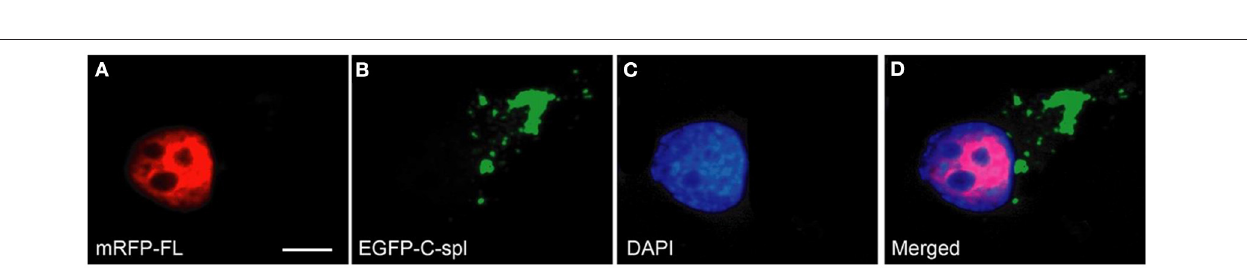
FIGURE 5 | Cytoplasmic aggregates of TDP43C-spl in neuronal cells labeled with ubiquitin antibody. N2a cells were transfected with EGFP-tagged TDP43-FL (A–D) or EGFP-tagged TDP43C-spl (E–H) . The EGFP-tagged TDP-43 isoforms are shown in (A,E) ; ubiquitin labeling in (B,F) ; DAPI stain in (C,G) ; with the respective merges shown in (D,H) . The EGFP-tagged TDP43-FL (A) co-localized with blue DAPI-staining nucleus (C) was not labeled by anti-ubiquitin antibody (B,D) . The EGFP- TDP43C-spl (E) and ubiquitin labeling (F) were co-localized to the cytoplasm [ (H) , areas of co-localization appear yellow]. Note regions that are ubiquitin-positive only [indicated by arrows in (H) ]. Scale bars = 15 µ m.